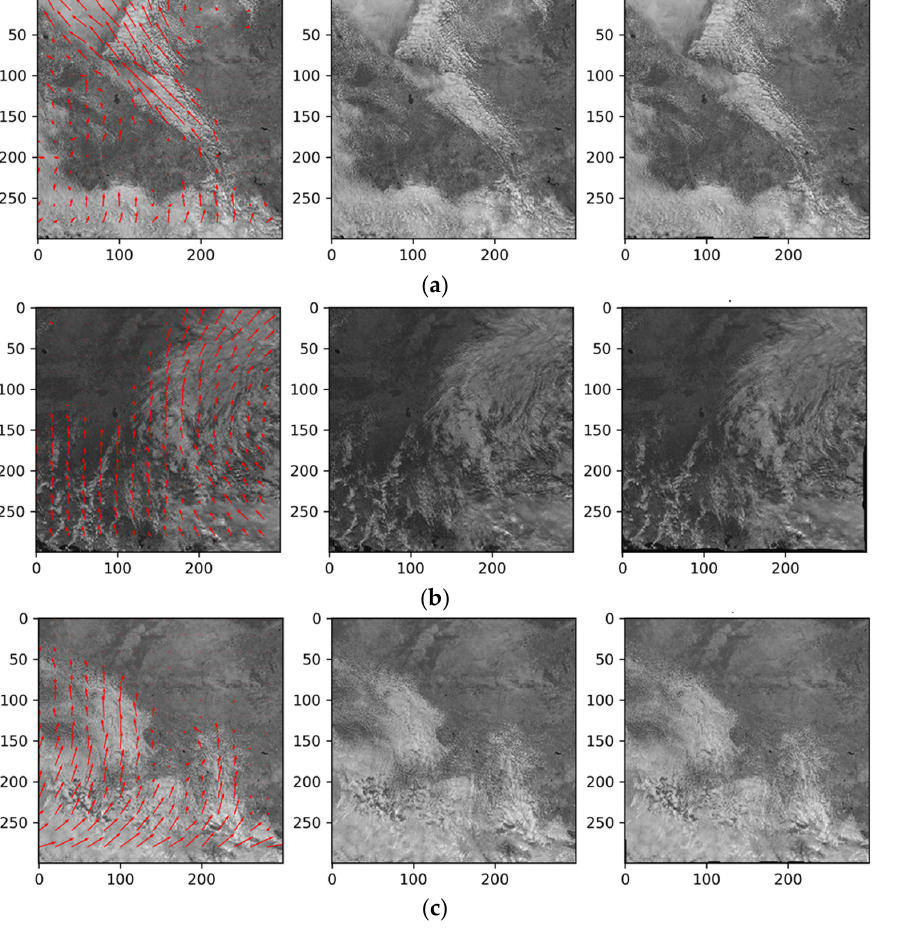
Figure A1. CMVs derived using optical flow techniques on ( a ) 1 June 2019, ( b ) 3 June 2019 and ( c ) 5 June 2019 with ( left ) the original image at noon with displacement vectors, ( centre ) true satellite image after 10 min from noon and ( right ) predicted image with a forecast horizon of 10 min using the displacement vectors derived from CMVs.